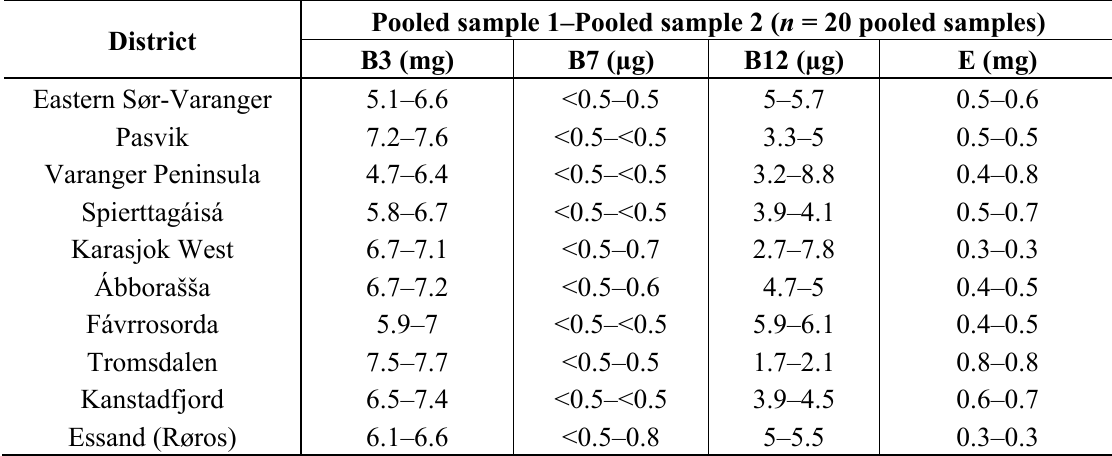
Table 5. Concentration of vitamins per 100 g reindeer meat (ww) from the different districts.